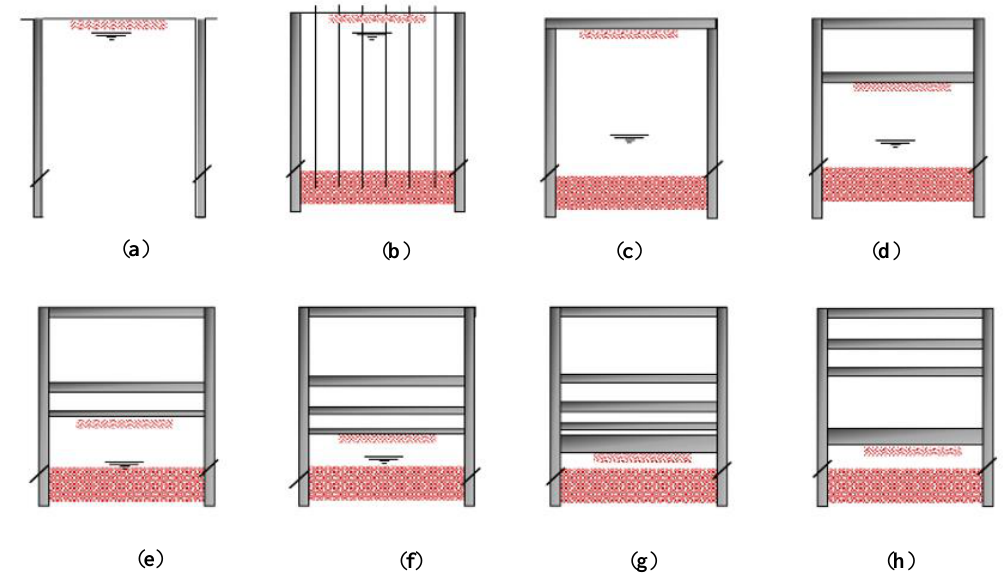
Figure 5. Stages of construction of Rod El Farag subway station case study [30]. ( a ) Stage 1: Wall construction. ( b ) Stage 2: Grouting. ( c ) Stage 3: Dewatering Excavation to roof slab level and concreting roof slab. ( d ) Stage 4: Excavation to technical slab level and concreting technical slab. ( e ) Stage 5: Excavation to the first layer of struts and installing the struts. ( f ) Stage 6: Excavation to the